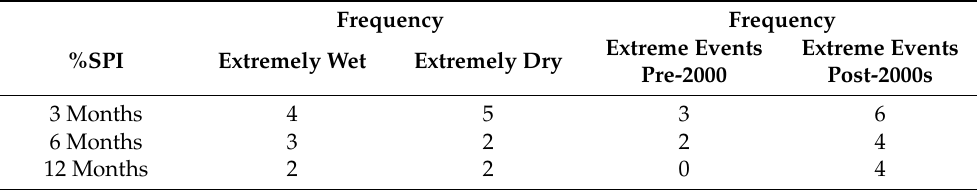
Table 5. Frequency and percentage of extremely wet and dry years in the Sipi sub-catchment between 1981 and 2015 under the 3-month, 6-month, and 12-month